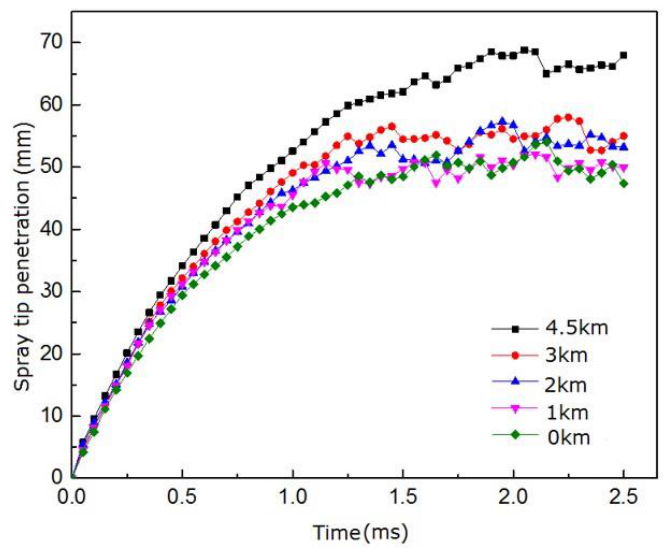
Figure 16. Comparison of spray tip penetration measured in a constant volume vessel at various altitudes (injection pulse = 2 ms, injection pressure = 40 MPa, and ambient temperature = 700 K).